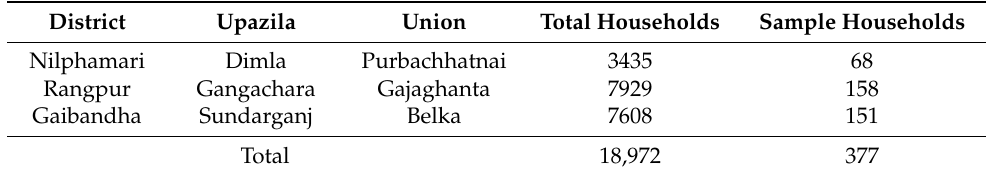
Table 1. Study area and population size (Source: Bangladesh Bureau of Statistics